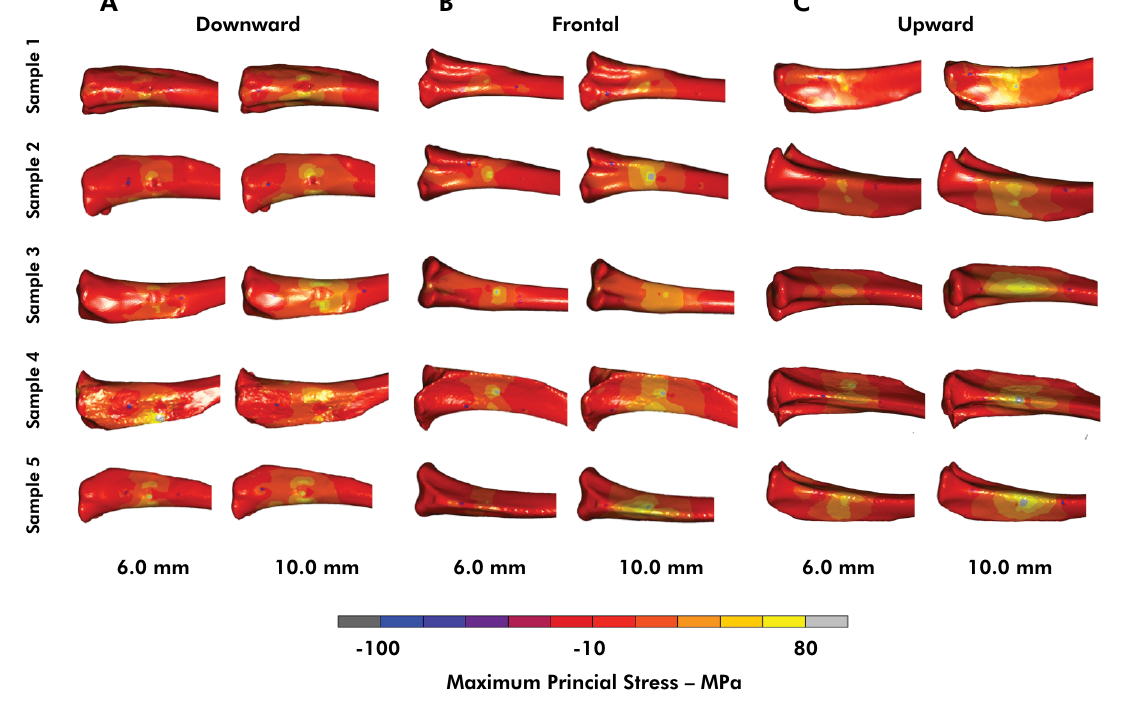
Figure 6. Maximum Principal Stresses (tensile stress) on the bottom of the bone, between the two spans of the bending test.